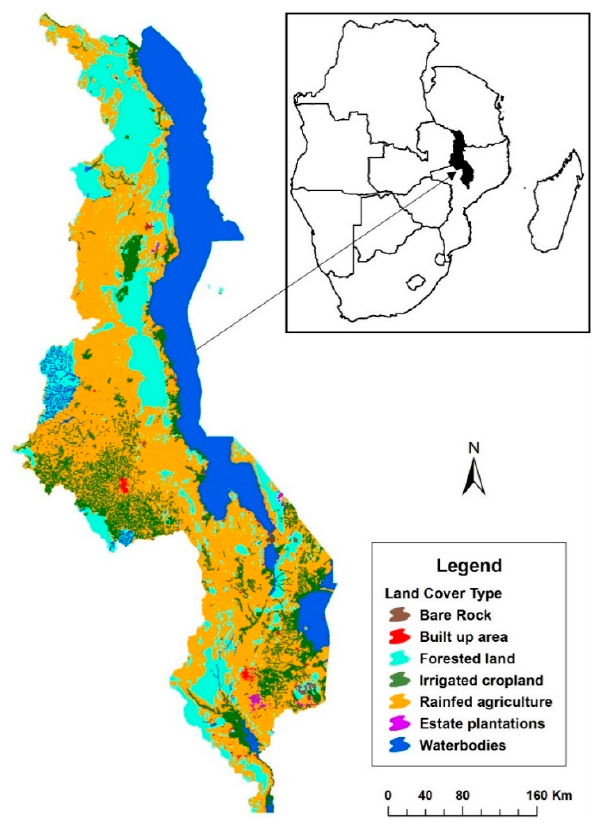
Figure 1. Landuse/cover and location map of Malawi.